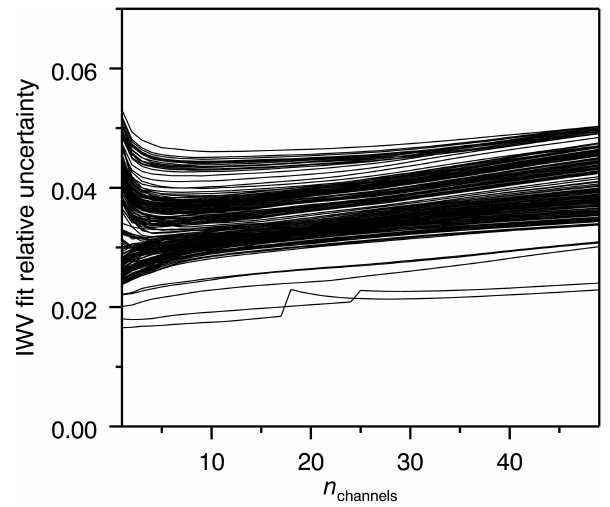
Figure A1. Relative uncertainty of the IWV fit depending on the number of spectral points n channels used in the fit for the spectra included in the FIR continuum data set. Channels are ordered by increasing type ii uncertainty. The number of channels used for the fit is adjusted in order to yield minimum overall